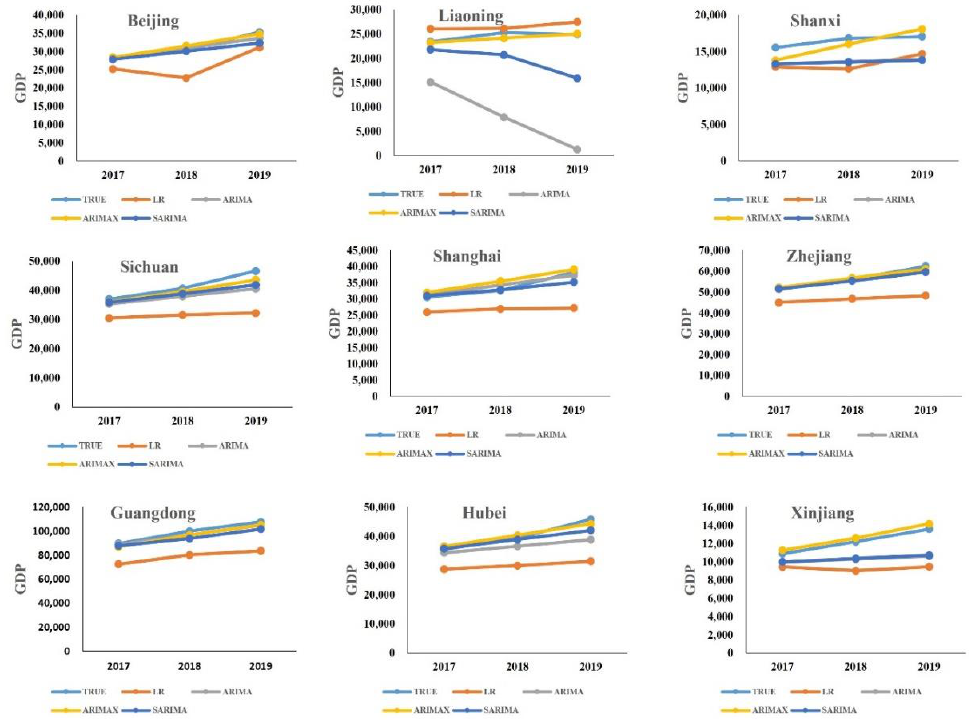
Figure 8. The GDP predicted by different models in selected Chinese provinces.